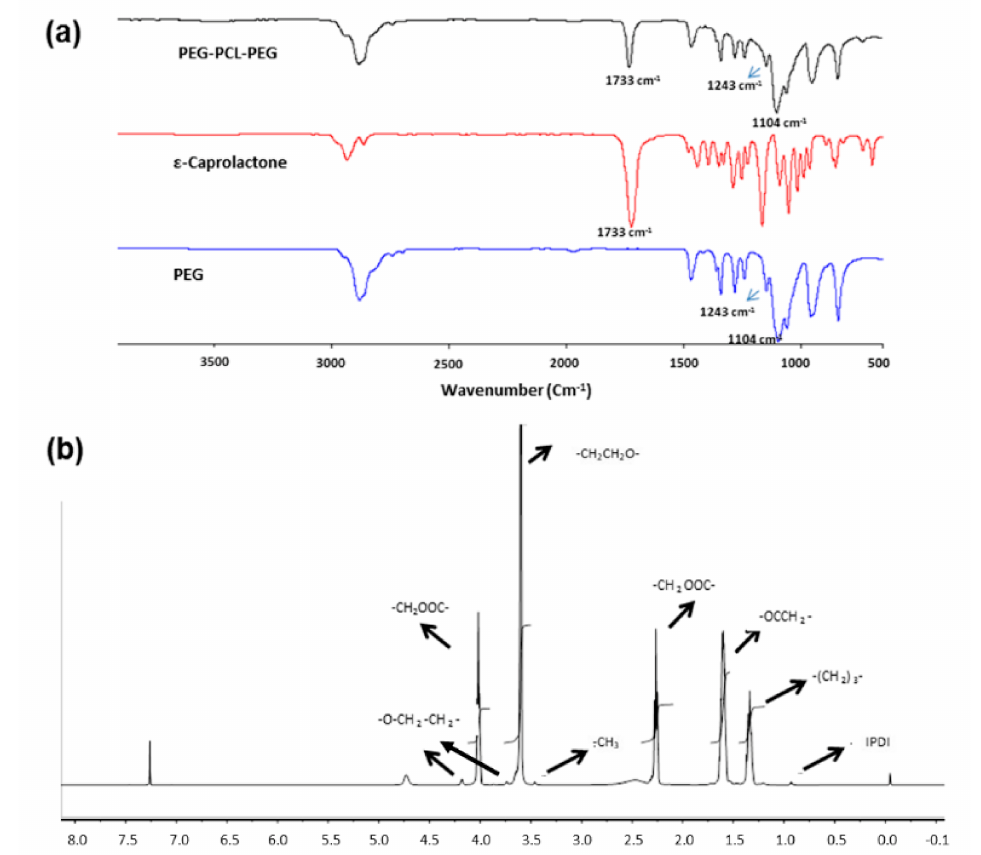
Figure 3. ( a ) Fourier-transform infrared spectroscopy of PEG, ε -caprolactone and PEG-PCL-PEG (polyethylene glycol-polycaprolactone-polyethylene glycol). ( b ) NMR spectroscopy of